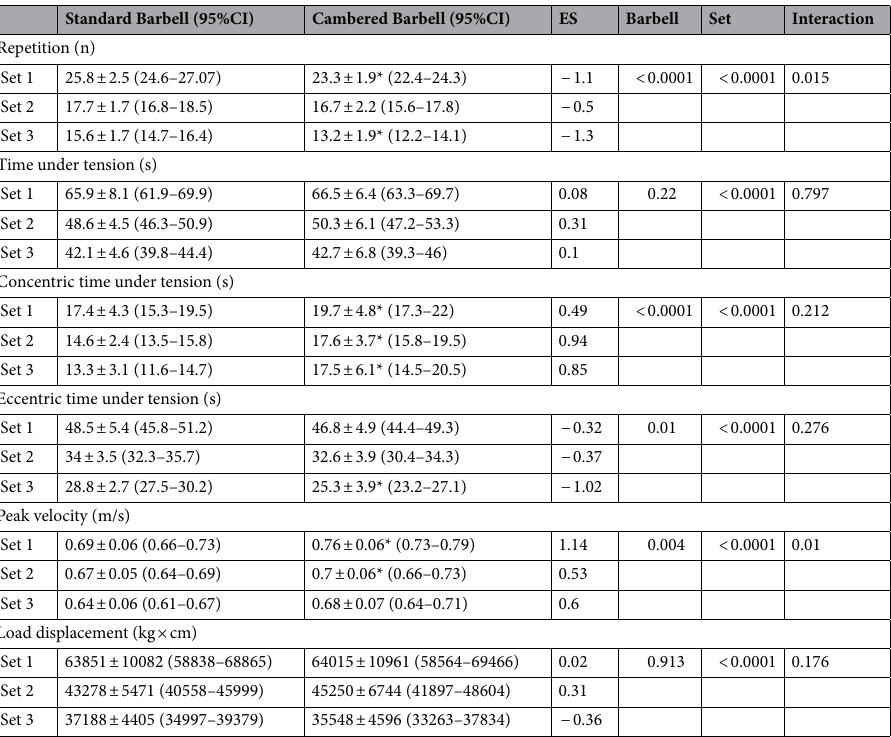
Table 3. Differences in performance variables during a standard and cambered barbell bench press. CI confidence interval, ES effect size. *p < 0.05 significant different from the corresponding value in the standard barbell bench